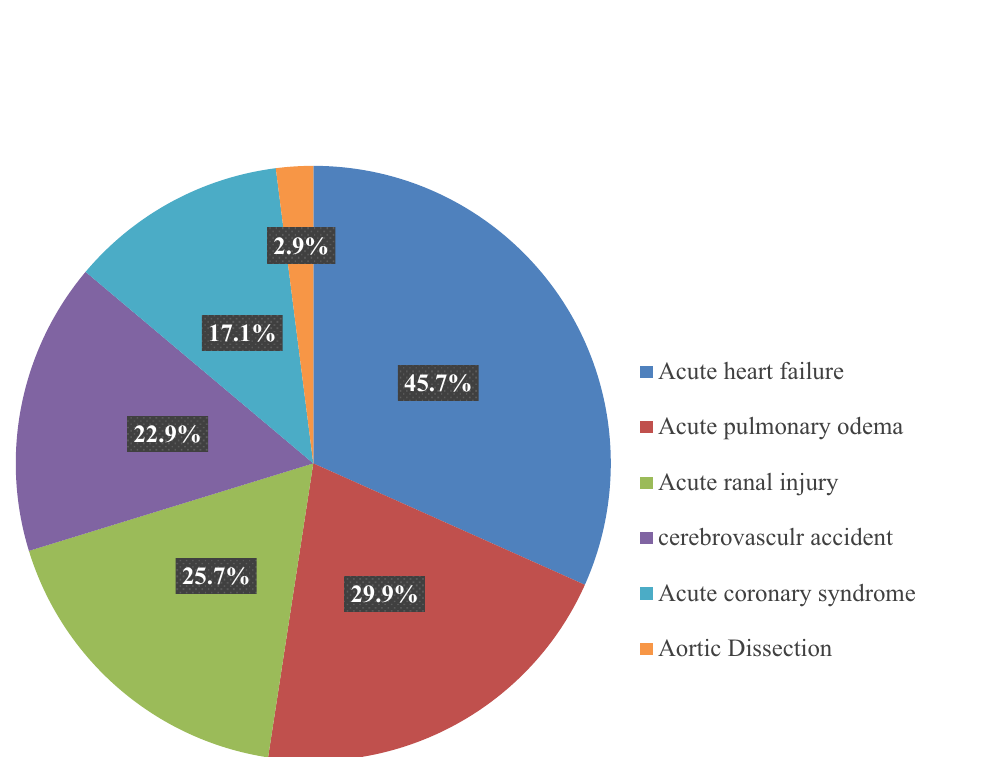
Table 4. Initial therapy of choice among patients with hypertensive crisis. HC hypertensive crisis, HE hypertensive emergency, HU hypertensive urgency.